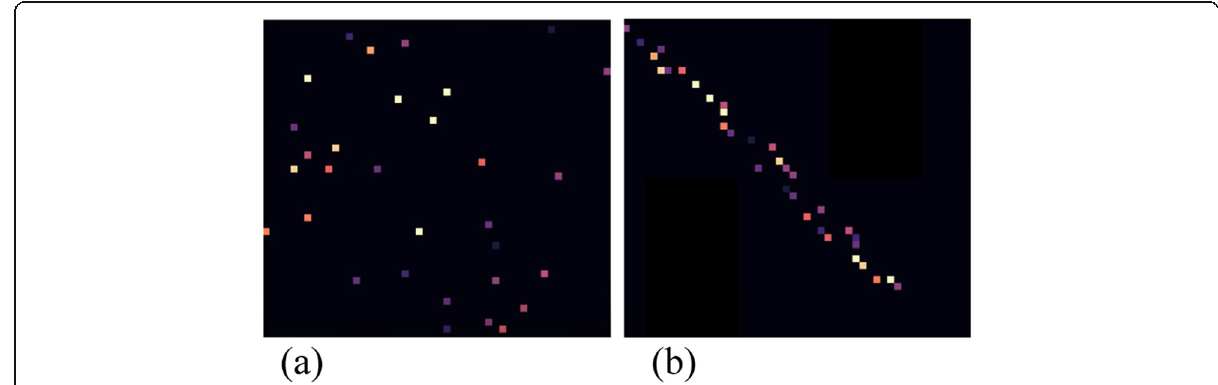
Fig. 6 Illustration of a reordering: a Original adjacency matrix; b Reordered matrix based on a Cuthill – McKee order